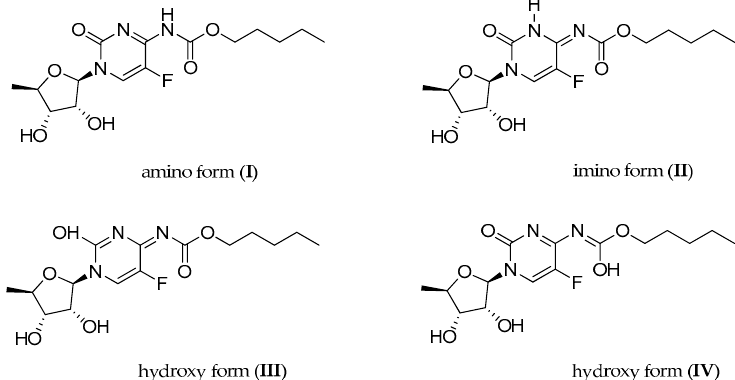
Figure 2. Possible tautomeric forms of capecitabine: I : carbamate-oxo, II : imine-oxo, III : imine- hydroxy, IV : enol-oxo.